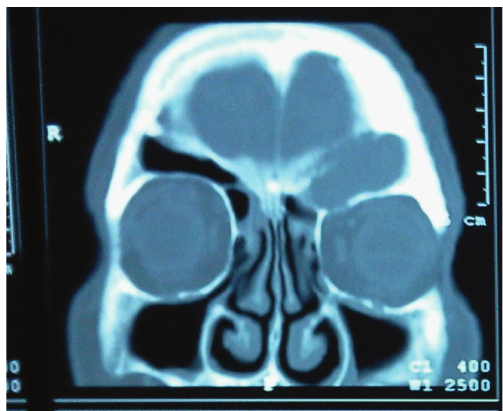
Figure 4: Postoperative